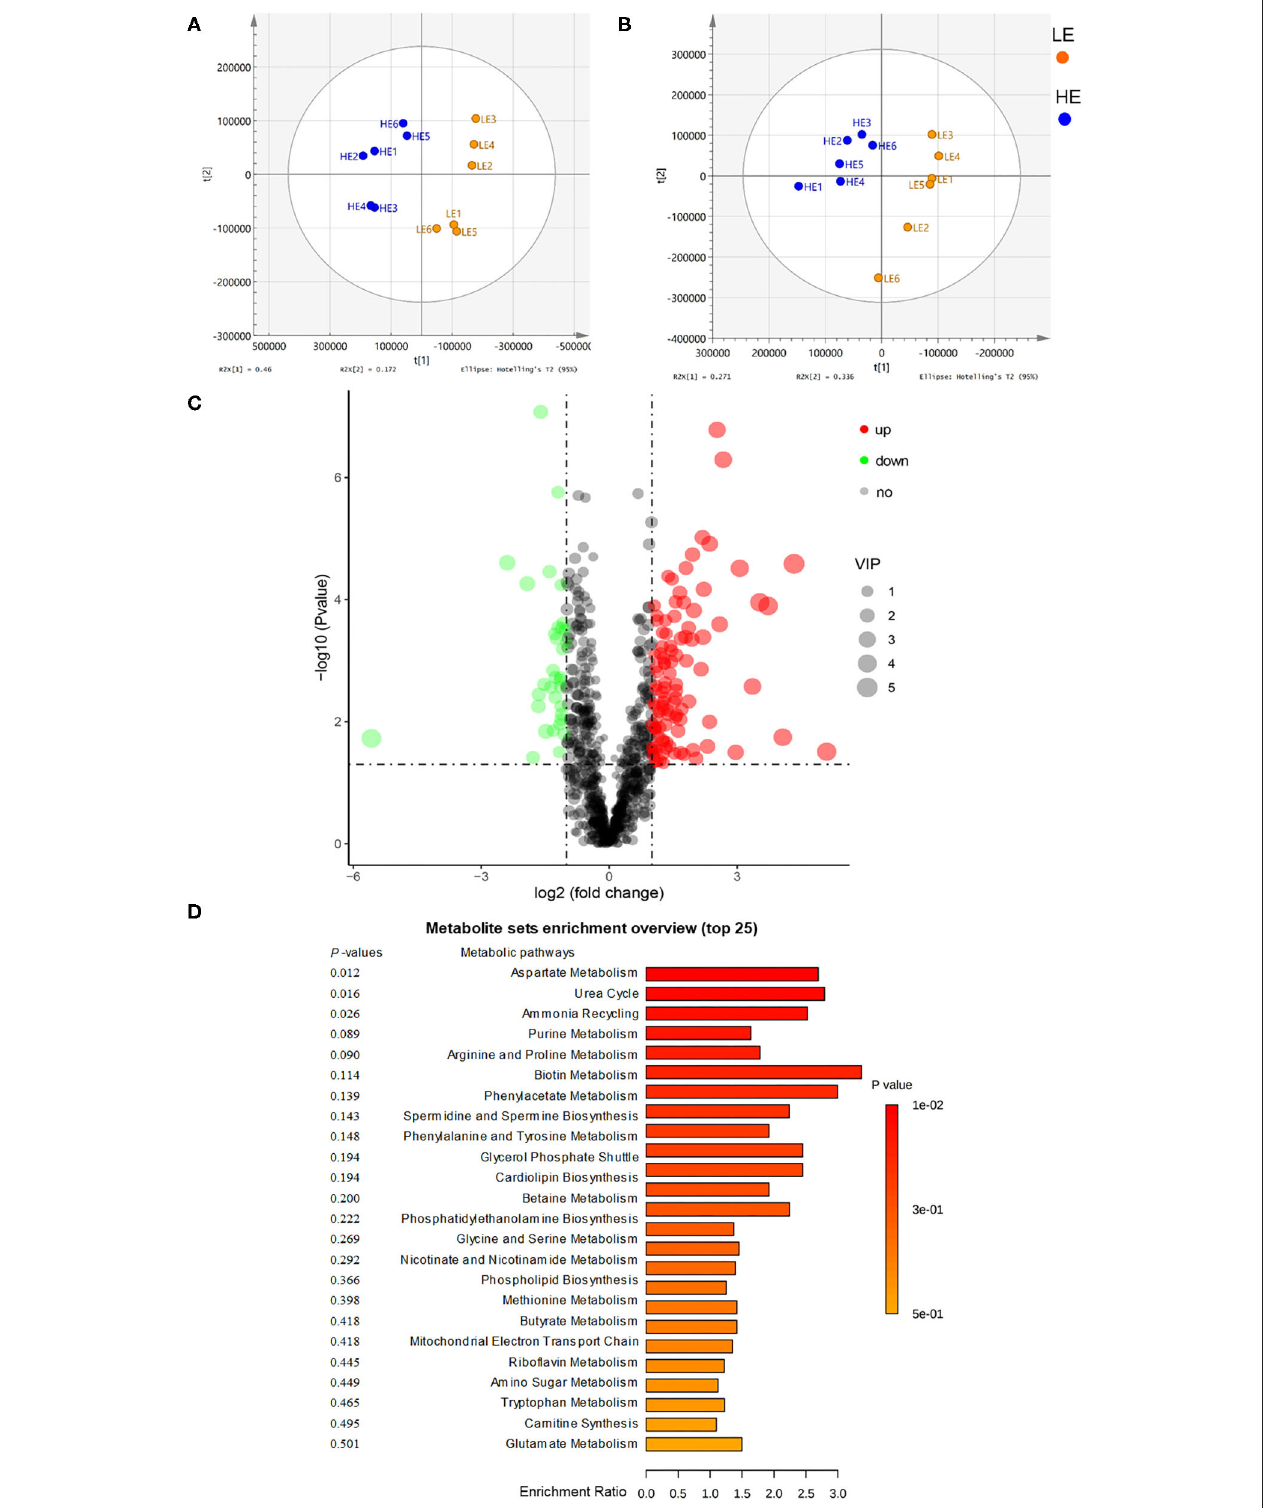
FIGURE 3 | Orthogonal partial least squares discriminant analysis (OPLS-DA) plot of rectal metabolites in comparisons of the LE and HE groups following (A) positive ion electrospray ionization (ESI + ) and (B) negative ion electrospray ionization (ESI–). (C) Identification of the differentially abundant metabolites between the LE and HE groups. Red represents an upregulation, while green represents downregulation; blue represents no change. (D) Enrichment analysis of metabolic pathways.